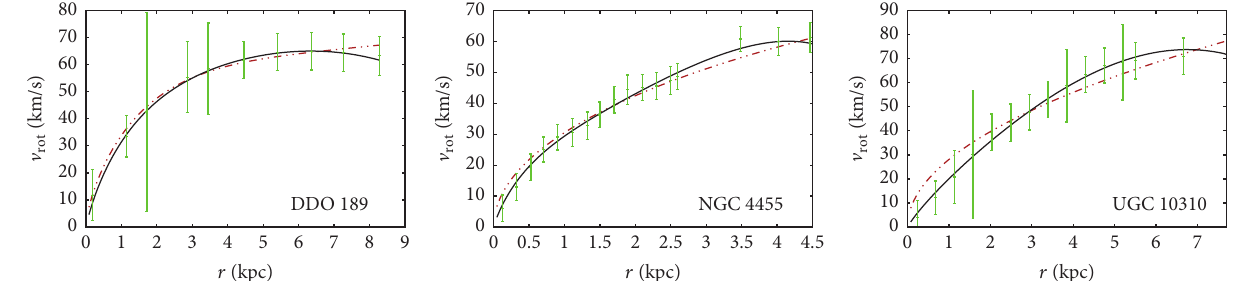
Figure 3: Best fit curves for the LSB I. galaxy sample. The solid black lines indicate the baryonic matter + BEC model, while the dashed red lines indicate the baryonic matter + NFW model.